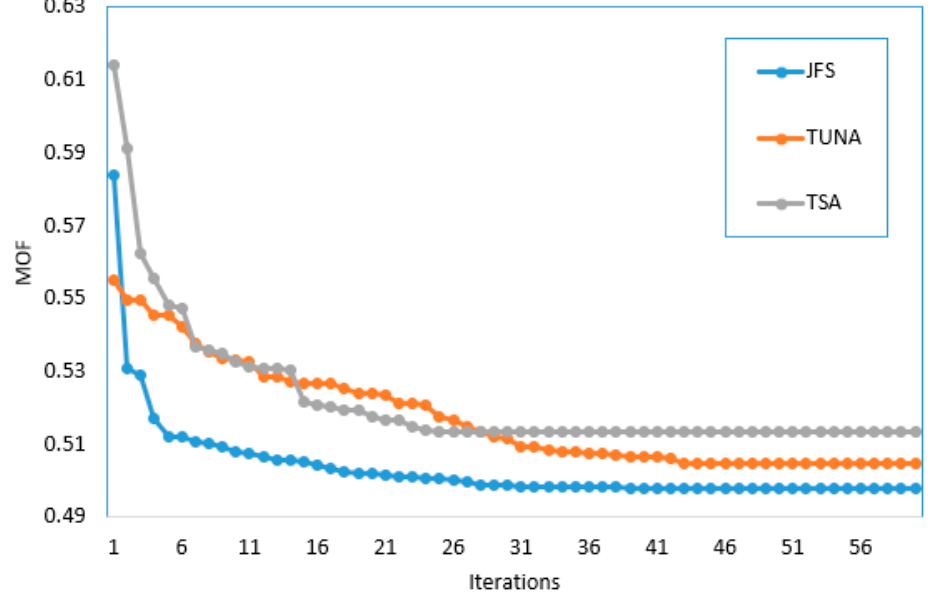
Figure 6. Convergence curves of TUNA, TSA and JFS algorithms for case 4.